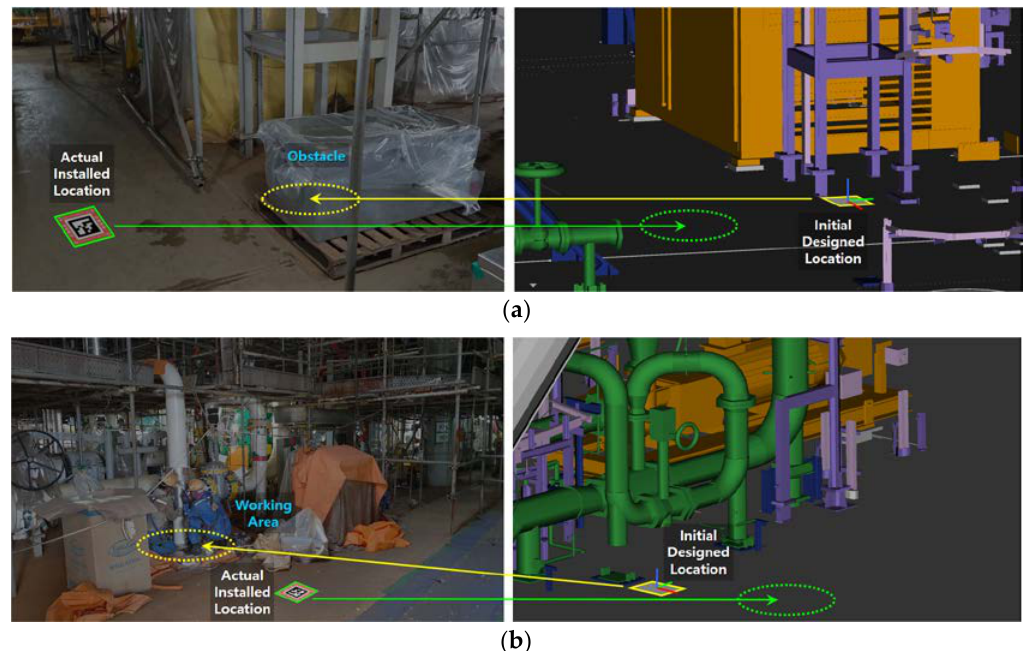
Figure 3. Problems of pre-registration and post-installation marker management. ( a ) Obstacle interference; ( b ) inaccessible area due to ongoing work.